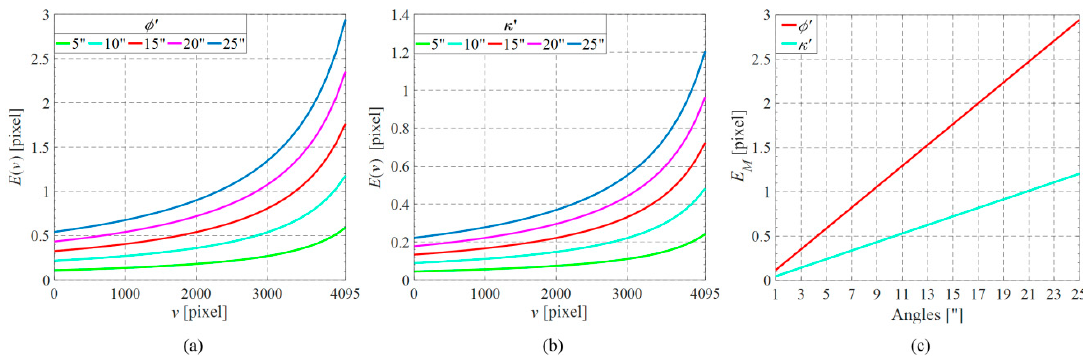
Figure 8. Simulation results of lateral errors with respect to various parameters. ( a ) Lateral errors with respect to the misalignment angle φ ’ ; ( b ) lateral errors with respect to the misalignment angle κ ’ ; and ( c ) the maximum lateral errors with respect to the misalignment angles φ ’ and κ ’ .